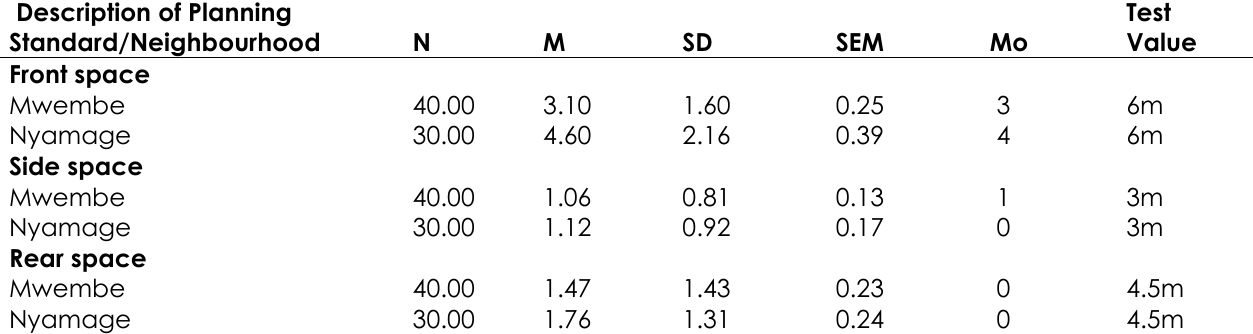
Table 4: One-sample statistics on compliance in Mwembe and Nyamage